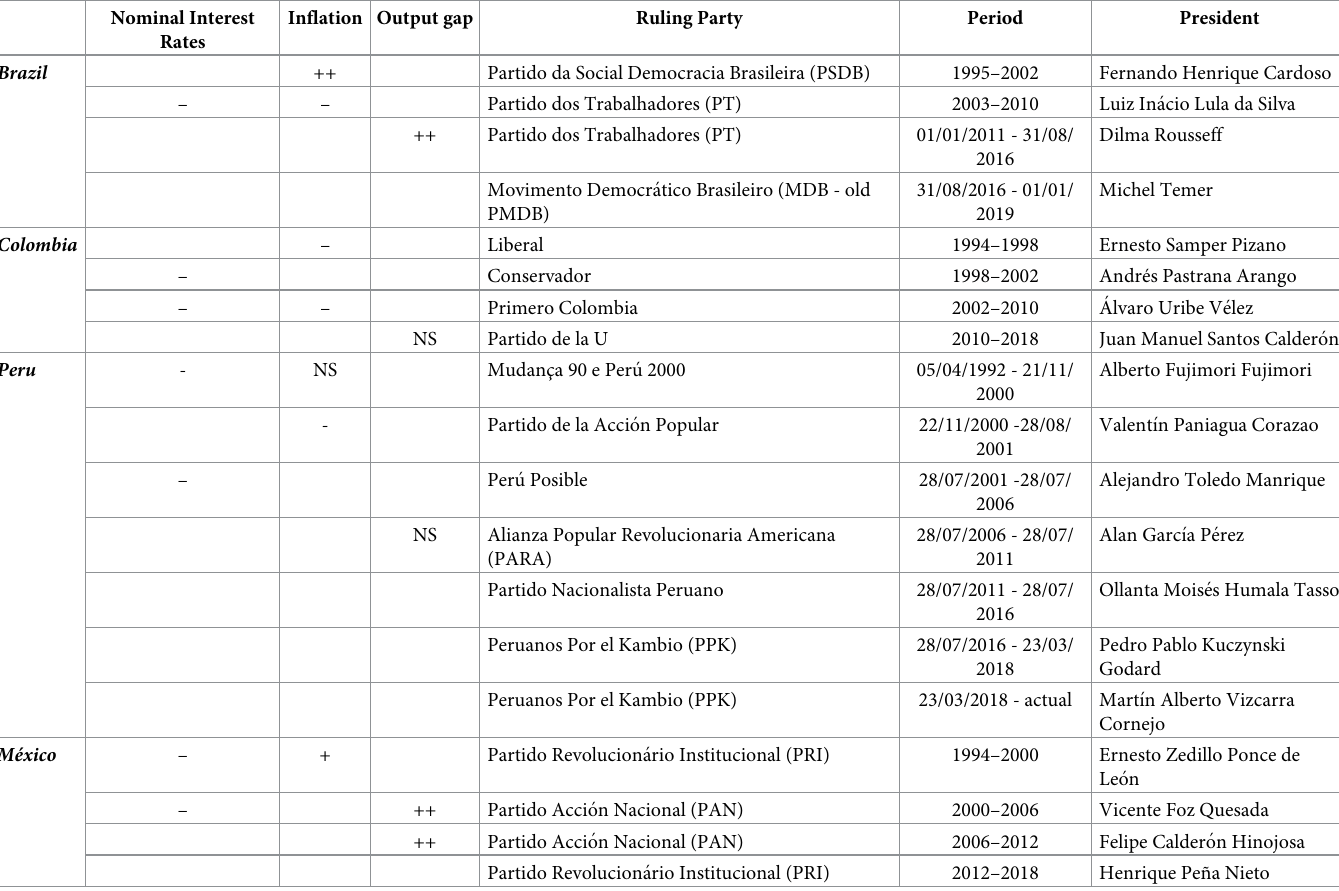
Table 6. Identification of significant changes in nominal interest rates, inflation and output gaps in Brazil, Colombia, Me´xico, and Peru (1995m1–2018m12). Nominal Interest